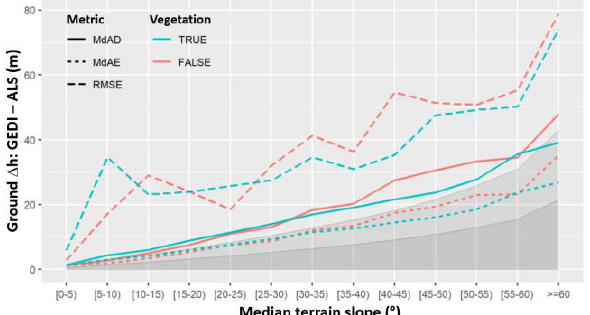
Figure 12. Accuracy metrics of terrain height with grey areas representing hypothetical vertical component of the 1 σ and 2 σ horizontal misplacement at each slope category.